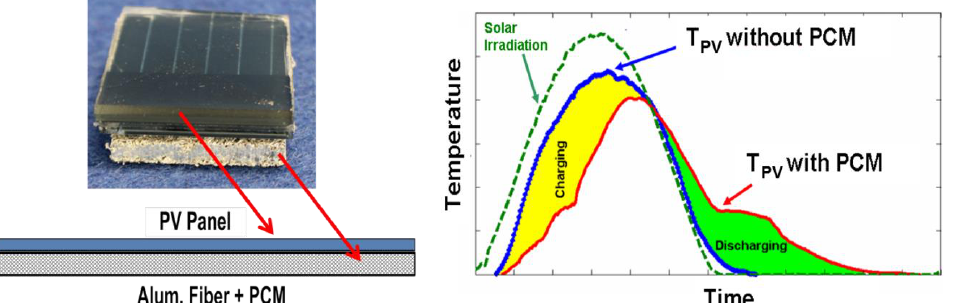
Figure 1. Passively cooled solar PV panel: ( Left ) photographic and schematic view of a cross-sectional sample of PV panel with PCM matrix absorber, and ( right ) illustration of day and night heat absorption (charging) and release (discharging); respectively.